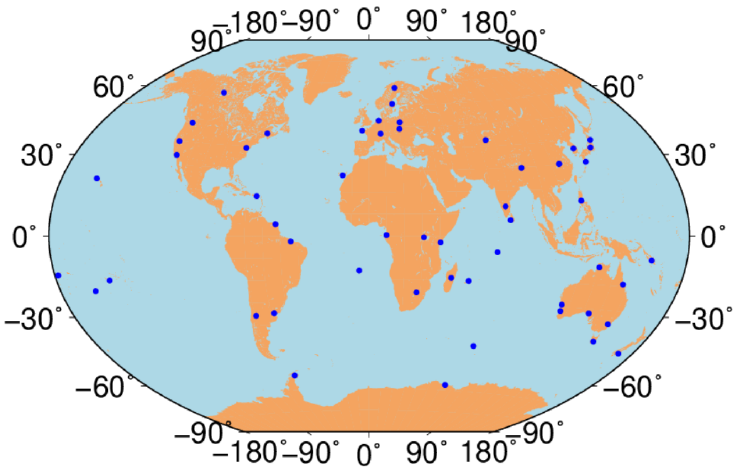
Figure 2. Distributions of the selected sites.